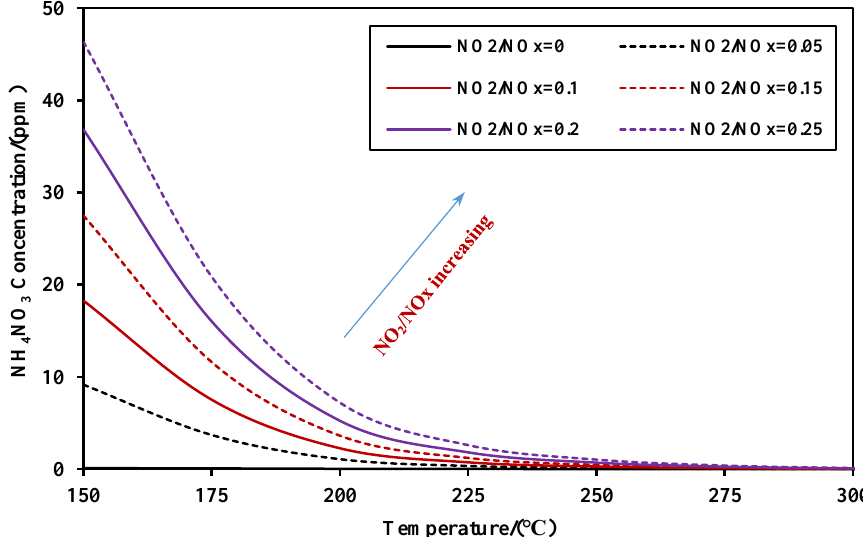
Figure 2. The influence of the reaction temperature and the NO 2 /NO x ratio on the formation of NH 4 NO 3 .